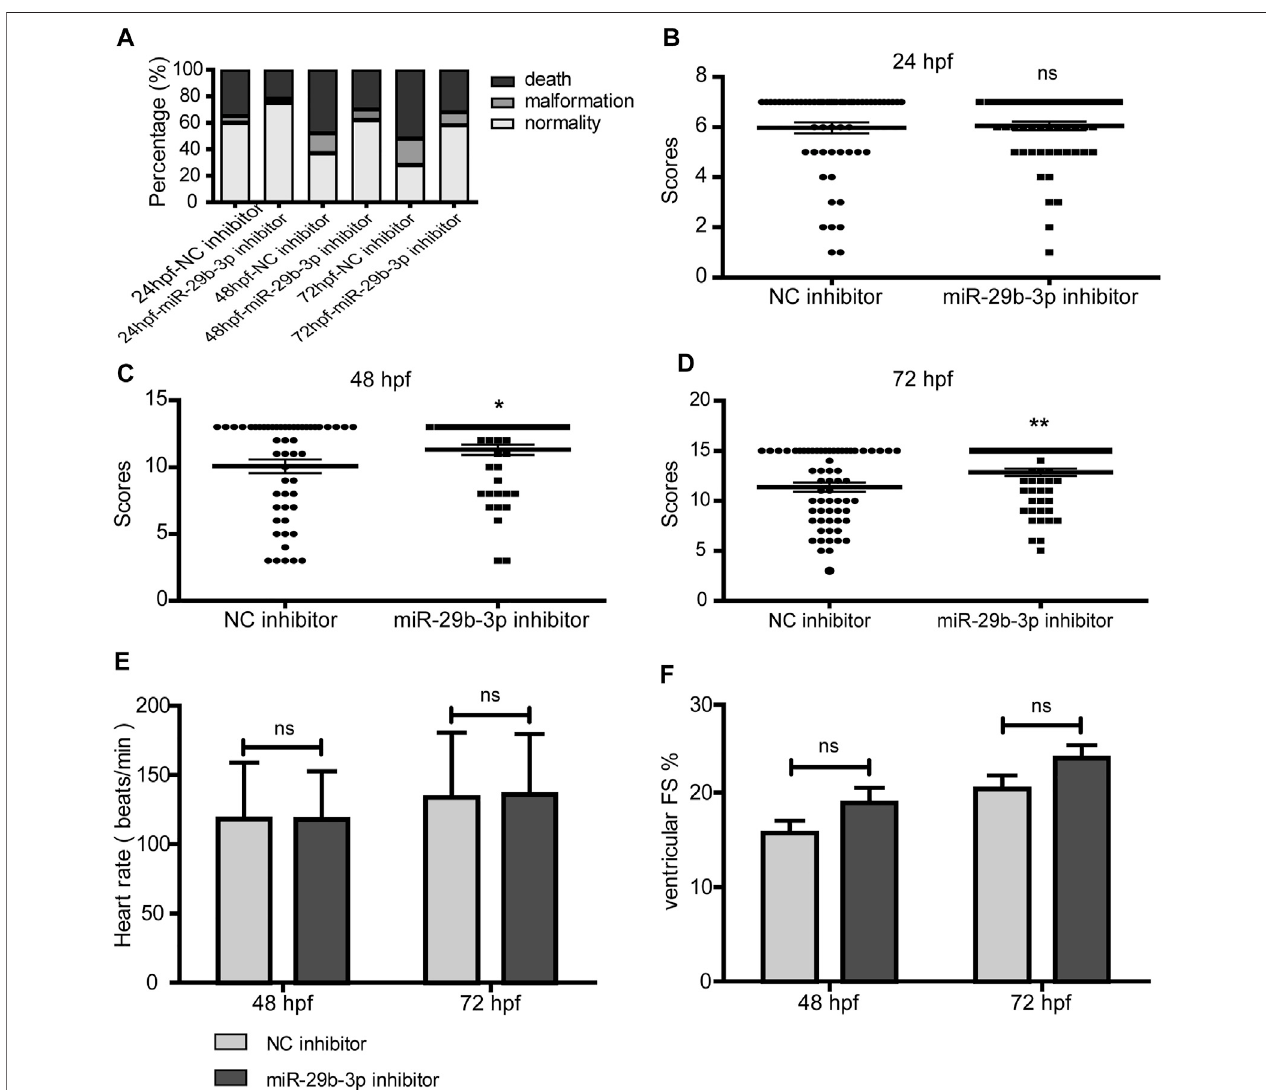
FIGURE 7 | The impact of miR-29b-3p inhibitor on the overall development of hypomethylated zebra fi sh embryos. (A) miR-29b-3p inhibitor partially reduced the mortality and deformity rates of zebra fi sh that resulted from 5-azacytidine exposure (n > 100). (B – D) The zebra fi sh general development score of the miR-29b-3p inhibitor group was signi fi cantly better than that of the NC inhibitor group at 48 hpf and 72 hpf (n > 50). (E and F) The heart rate and fractional shortening of zebra fi sh embryos coinjected with 5-azacytidine and miR-29b-3p inhibitor displayed no signi fi cant difference from those of the 5-azacytidine and NC inhibitor groups (n =